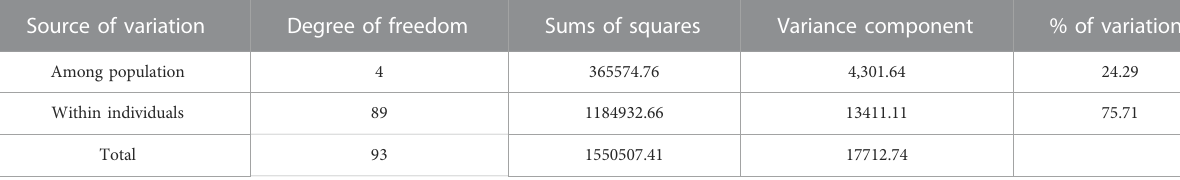
TABLE 2 Analysis of molecular variance among fi ve cattle breeds. Source of variation Degree of freedom Sums of squares Variance component